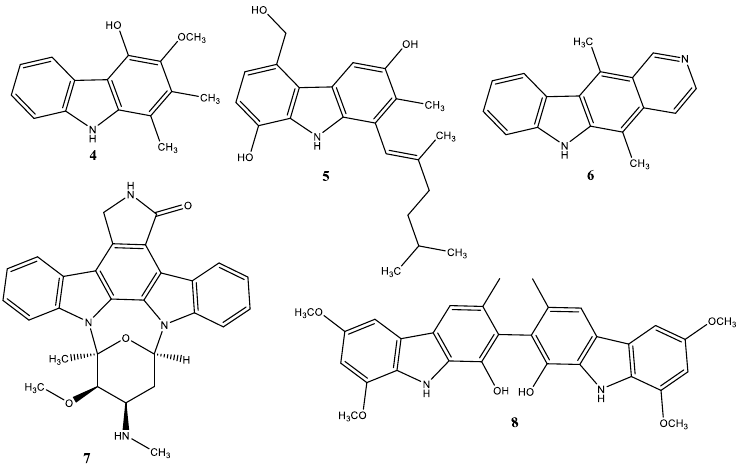
Figure 3. Structures of: carbazomycin B ( 4 ), carbazomadurin A ( 5 ), ellipticine ( 6 ), staurosporine ( 7 ), clausenamine A ( 8 ).